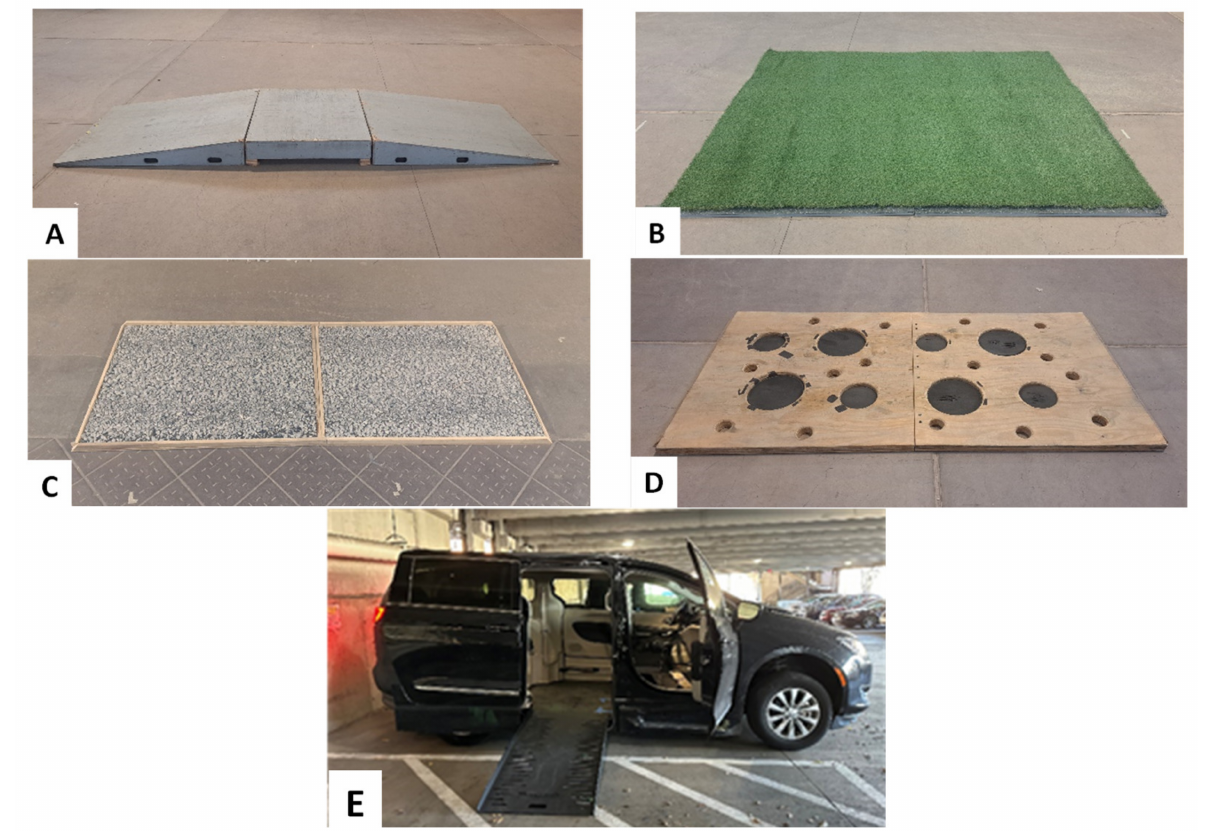
Figure 3. Wheelchair test course. ( A ) Curb cut, ( B ) Grass, ( C ) Gravel, ( D ) Potholes 1” depth, ( E ) Accessible